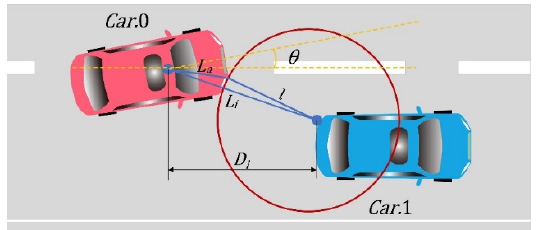
Figure 6. The relationship between 𝐶𝑎𝑟. 0 and 𝐶𝑎𝑟. 1 avoiding